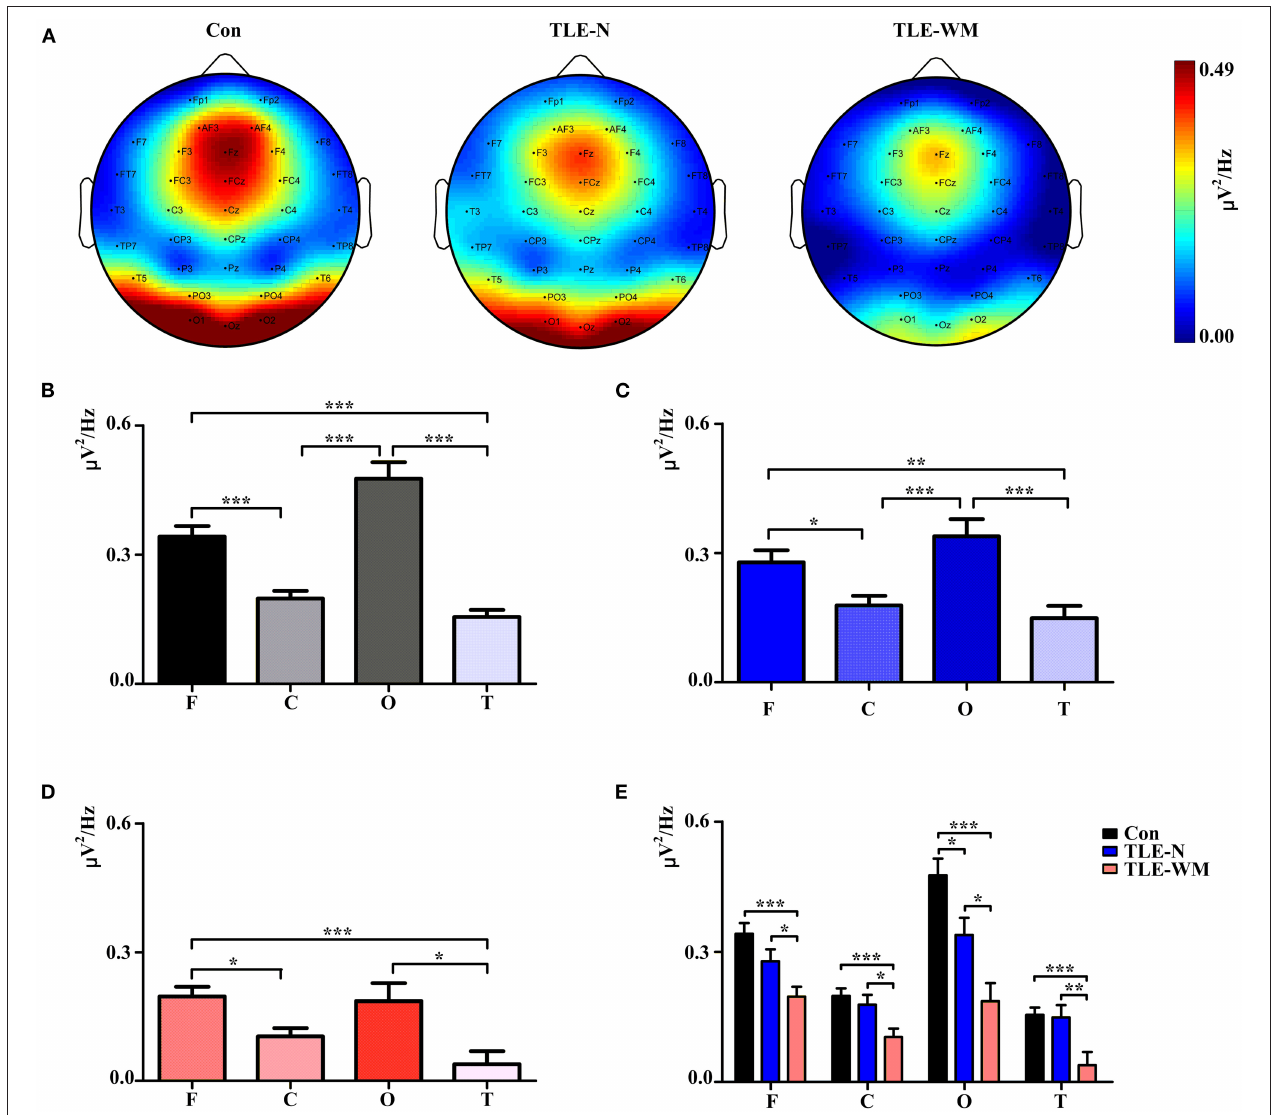
FIGURE 4 | Spectral distribution and histogram of theta power during the WM encoding phase in the three groups. (A) Spectral distribution of theta power in the three groups. Power is indicated by color. Histogram of theta power in different brain regions for the Con group (B) , the TLE-N group (C) , and the TLE-WM group (D) . (E) Comparisons of theta power associated with different brain regions across the three groups. C, central-parietal region; F, frontal region; T, temporal region; O, occipital region. * p < 0.05, ** p < 0.01, and *** p < 0.001.